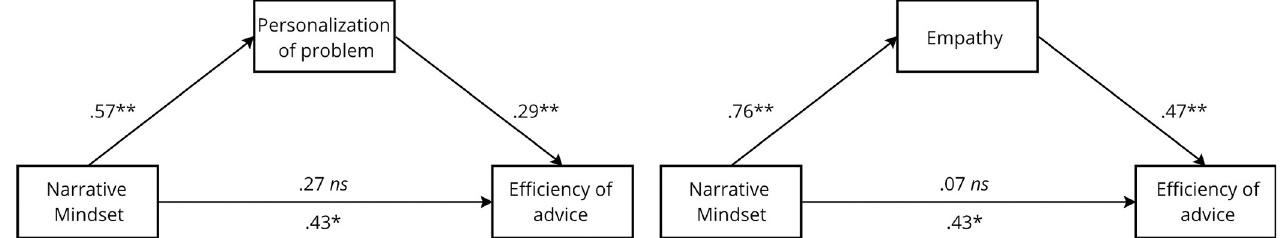
Fig 3. Mediating effect of personalization of problem and empathy on the association between narrative mindset and effectivity of advice–two separate simple mediation models (the emotional problem-solving study). Note : Presented regression coefficients were partially standardized for the narrative mindset predictor. The remaining were fully standardized. Coding for the independent variable: 0 –control, 1 –experimental. � p < .05. �� p < .01. ��� p < .001.